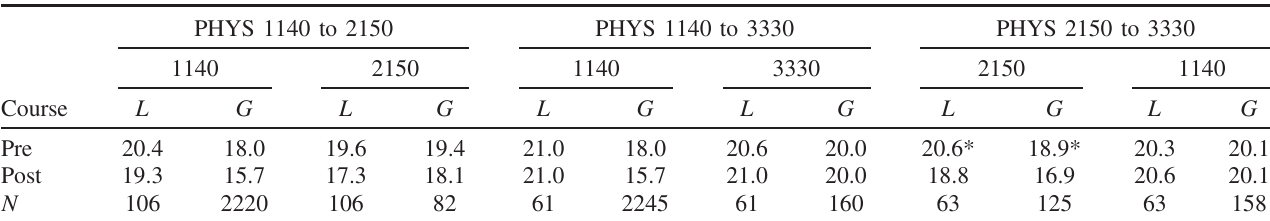
TABLE IV. Overall E-CLASS averages (max score 30) for students in each of the three longitudinal populations. The longitudinal students ( L ) represent students for whom we have matched pre- and postinstruction responses in both courses in question. The general students ( G ) represent all students for whom we have matched pre- and postinstruction responses for only the given course (minus the longitudinal students). Differences between scores for longitudinal and general students in a given course are statistically significant (Mann-Whitney U p < 0 . 05 ) for the lower level of the two course in all cases except one (denoted by asterisks), while the same difference for the higher level of the two courses is statistically insignificant in all